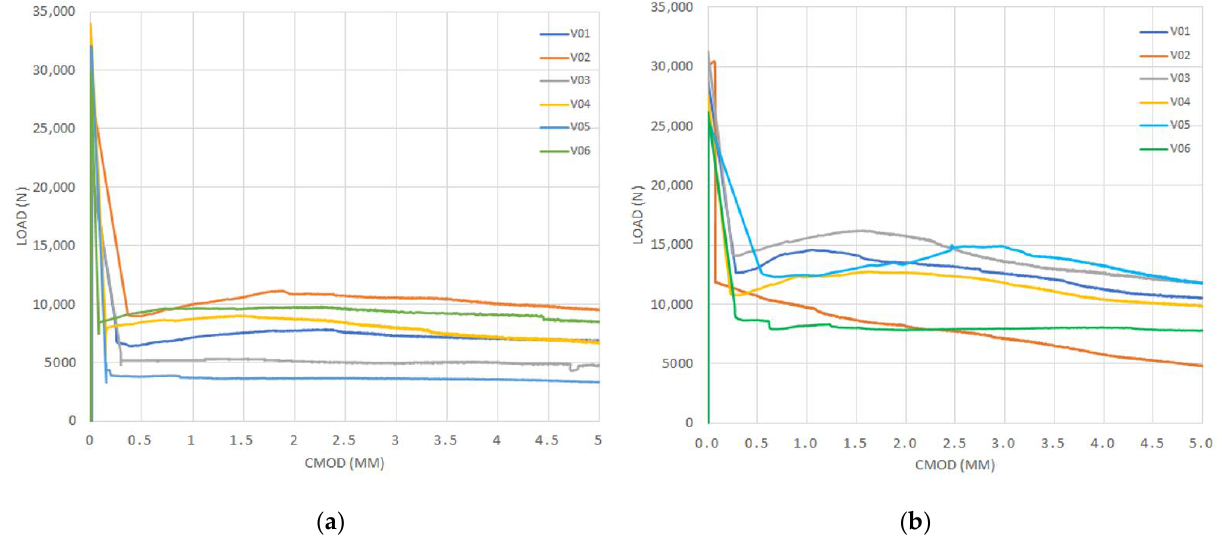
Figure 5. Curves of bending tensile test for the ratio (a/d) = 0: ( a ) Series 1 and ( b ) Series 2.